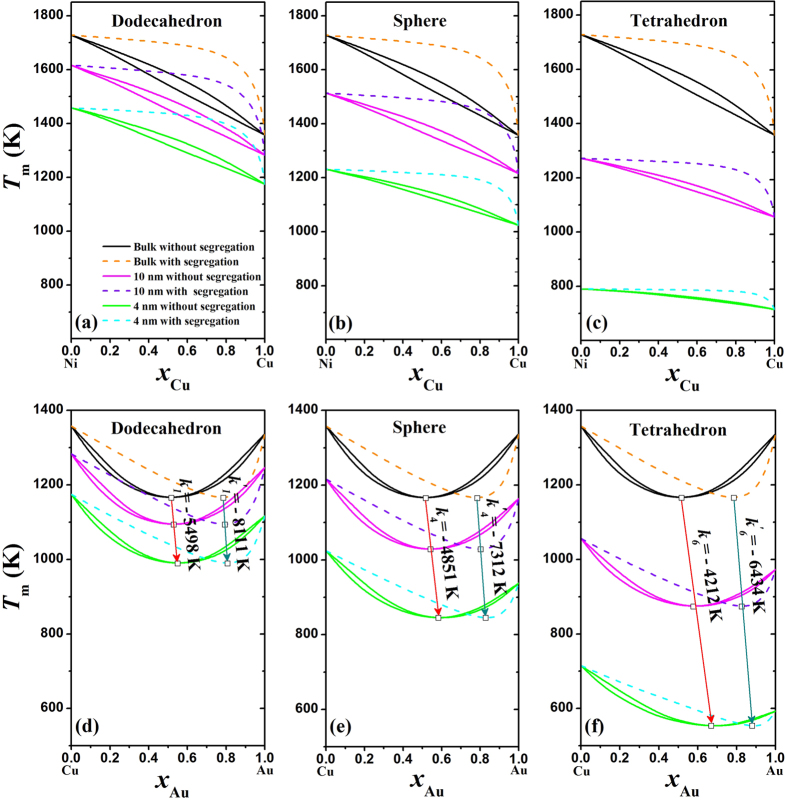
Solidus(core)/liquidus(core) and solidus(surface) of dodecahedral, spherical, and tetrahedral Ni-Cu (a–c) and Cu-Au (d–f) nanoalloys without and with surface segregation at bulk, 10, and 4 nm, where the red and cyan arrows are only to guide the eyes and highlight the size and shape effects on the congruent melting point, respectively.